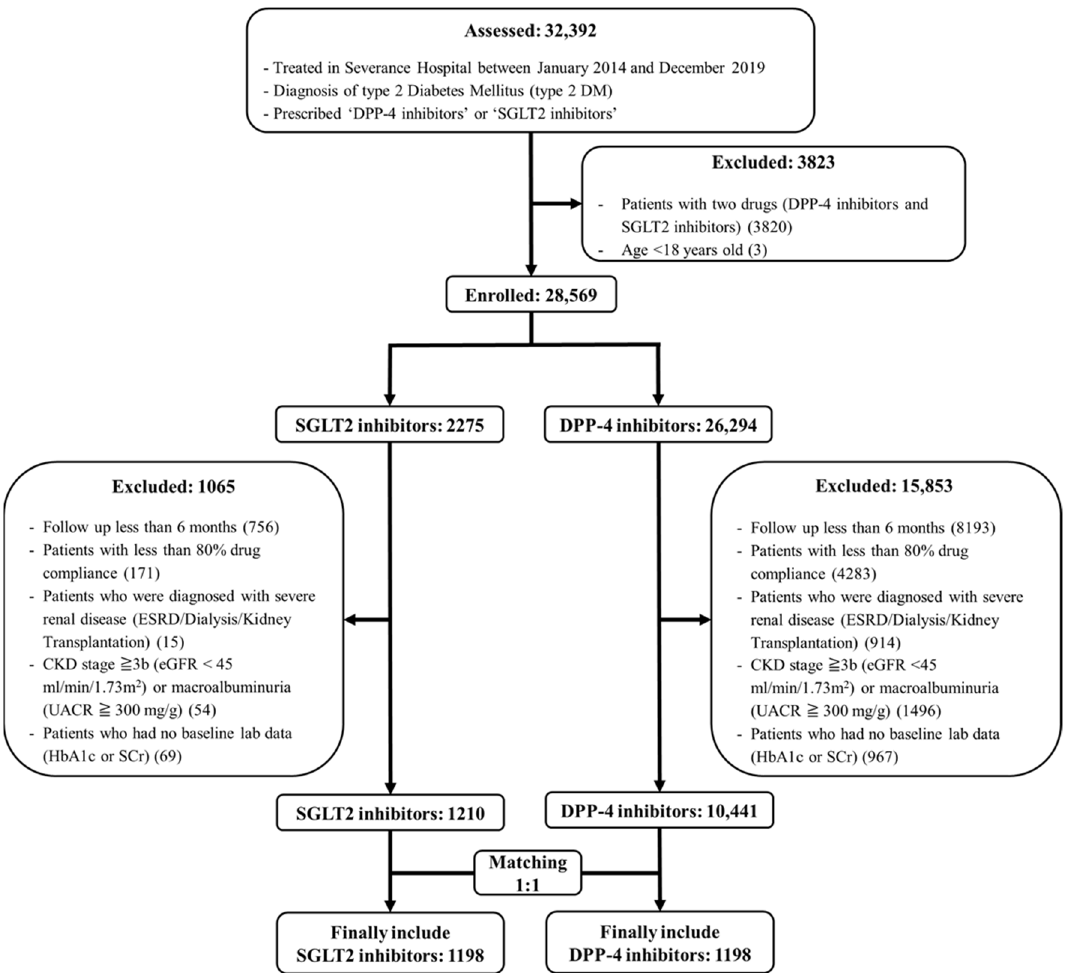
Figure 1. Flowchart of patient inclusion and exclusion. CKD, chronic kidney disease; DPP-4 dipep- tidyl peptidase-4; eGFR, estimated glomerular filtration rate; ESRD, end-stage renal disease; HbA1c, glycated hemoglobin; SCr, serum creatinine; SGLT2, sodium–glucose cotransporter-2; UACR, urine–albumin–creatinine ratio. Table 1. Baseline characteristics of propensity-score-matched pairs of the SGLT2 inhibitors group and DPP-4 inhibitors group .